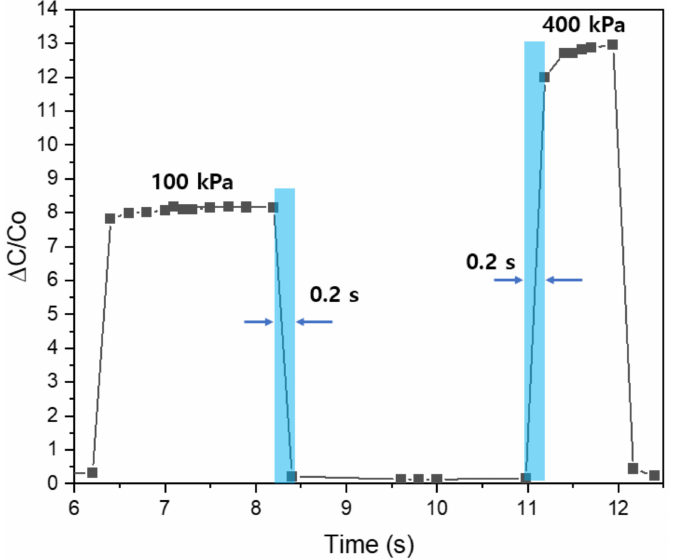
Figure 16. Pressure-response time of capacitive pressure sensors at 100 kPa and 400